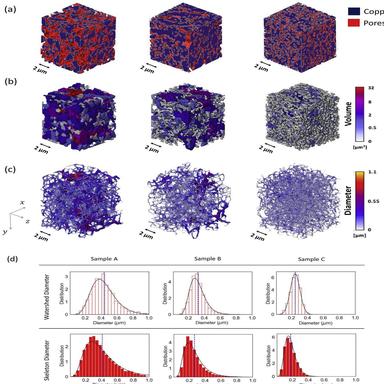
Segmented 3D data for sample A, B and C (from left to right) using the hybrid image analysis method and pore size distribution. (a) Rendered binary 3D VOI with copper (dark blue) and pore phase (red). (b) Watershed algorithm applied for the three samples. The selected bin number is 2. The color refers to the volume of the individual pore segments i, with i = 1,2,3, …. (c) Skeletonization of the three samples. The color code represents the local diameter of the pores. (d) The pore diameter size distribution